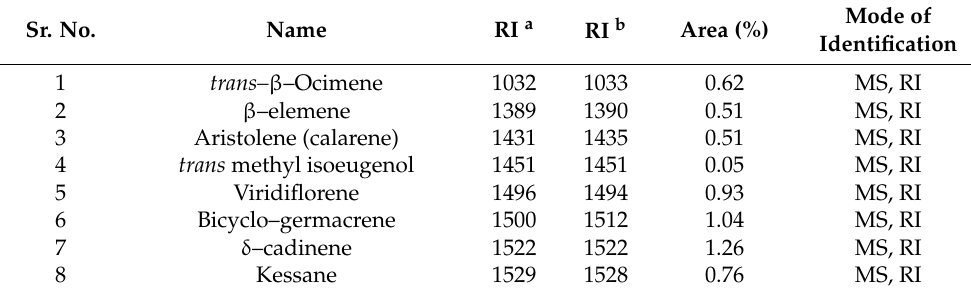
Table 1. Chemical composition of essential oil of A. calamus